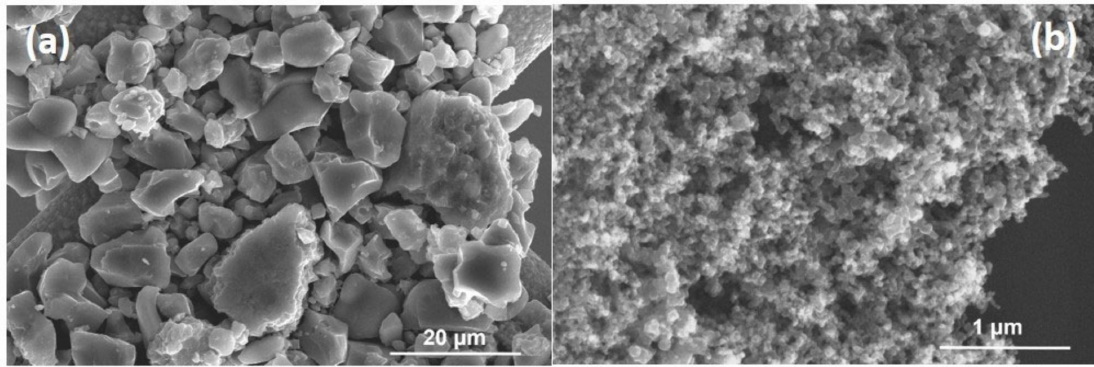
Figure 2. SEM micrographs of as-received micro-TiN ( a ) and nano-TiN ( b ) powders. As shown in the Figure 2, micro-TiN powders exhibit irregular particle shape with board size distribution raging from submicron to 20 µ m, while nano-TiN powders show a more homogenous grain distribution with dimension in the 30–50 nm range. The spe- cific surface areas of as-received micro-TiN and nano-TiN powders are 2.38 m 2 /g and 33.24 m 2 /g respectively. Figure 3 shows XRD patters of as-received micro-size and nano- size TiN powders.